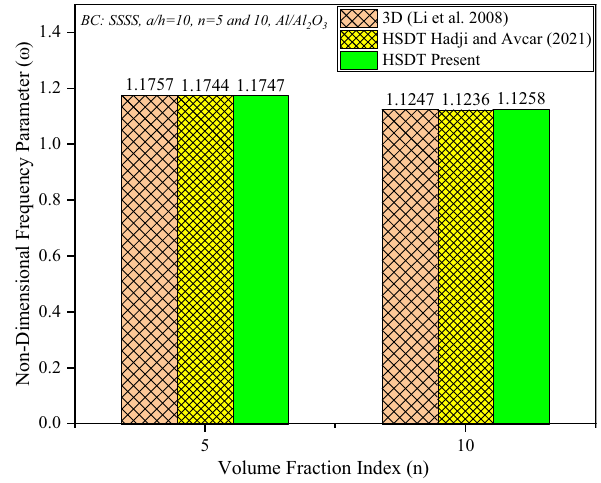
Figure 7: Validation for NDFP of SFGM square plate under the SSSS boundary condition using ( 1 - 2 - 1 ) con fi guration and Al/Al 2 O 3